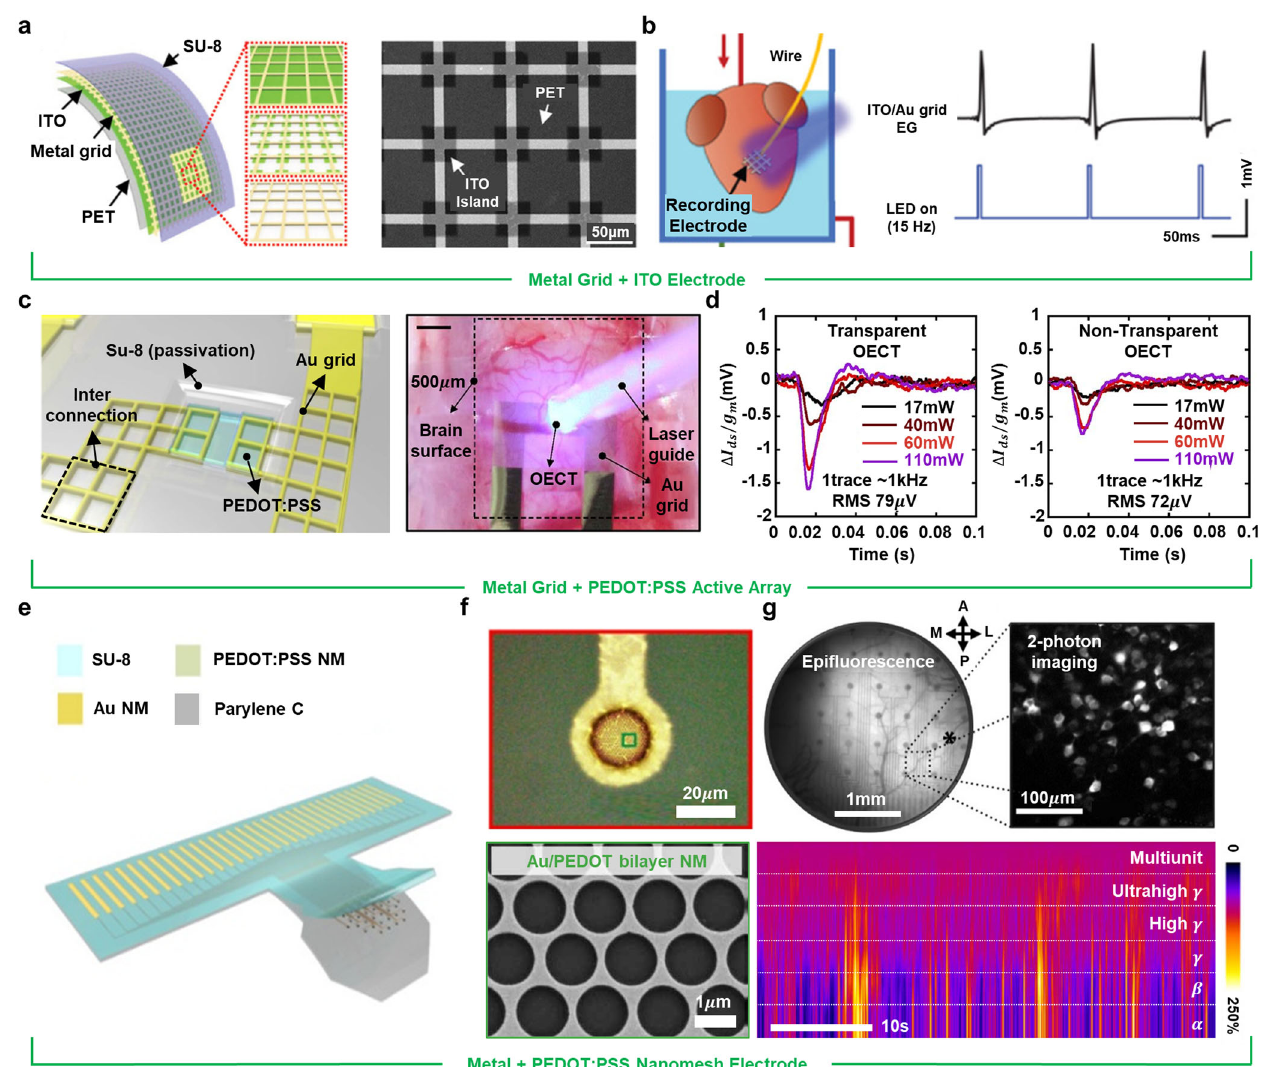
Fig. 6 Mesh structured transparent electrode arrays for multimodal sensing and stimulation of neuro-dynamics. a Transparent microelectrode arrays based on an Indium Tin oxide (ITO)/metal grid hybrid (left), metal grid on an ITO fi lm (inset top), metal grid on an ITO island (inset middle), metal grid (inset bottom), and scanning electron microscopy (SEM) image of an ITO island with a metal grid (right). b Langendorff perfusion experiment setup for recording the electrophysiological signal and optogenetics simultaneously on the hearts of mice (left), and the recorded QRS complex with microelectrodes induced by blue light emitting diode (LED) (right). c Single cell in a transparent organic electrochemical transistors (OECTs) array (left), and conformally contacted transparent OECT on a cortical surface of a transgenic rat, stimulated with a blue laser (right). d In vivo evaluation conducted with transparent and non-transparent OECTs, and recorded electrocorticography (ECoG) signals evoked with blue light stimulation depending on excitation intensities. e Illustration of a transparent multichannel Au/PEDOT:PSS bilayer micro-electrode array (MEA). f Microscope image of a bilayer MEA (top), SEM image of a bilayer nanomesh MEA (bottom). g Simultaneous electrophysiological recording (bottom) and two-photon imaging (top right) through an epicortical bilayer MEA on the visual cortex of mice. Panels a and b reprinted with permission from ref. 162 , PNAS; panels c and d reprinted with permission from ref. 167 , PNAS; panels e, f, and g reprinted with permission from ref. 25 ,